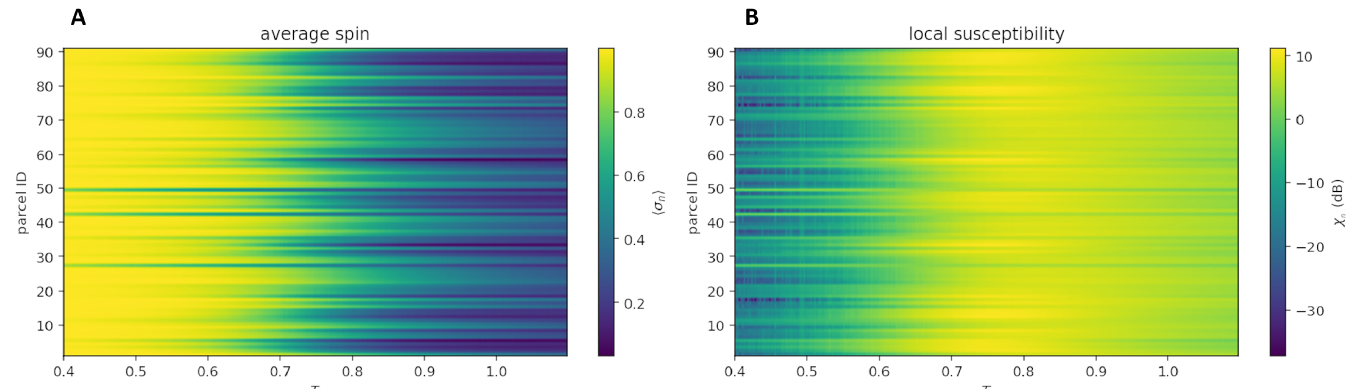
Fig 2. Local magnetization and susceptibility as a function of temperature from Metropolis simulations with the global archetype model. A) Local magnetization and B) local susceptibility (i.e., specific to each spin or brain parcel).